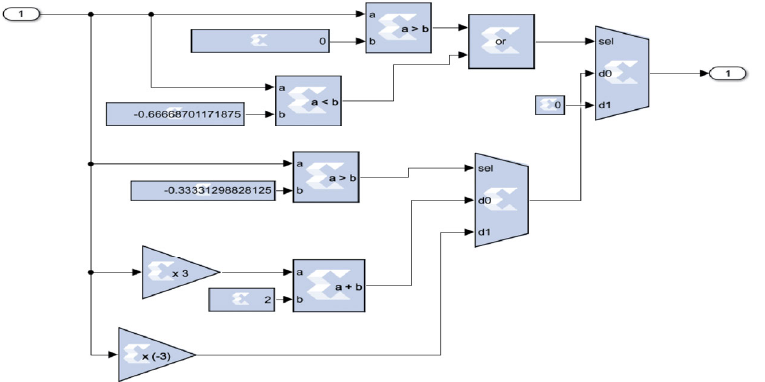
Figure 19. Design of membership function NS from XSG.